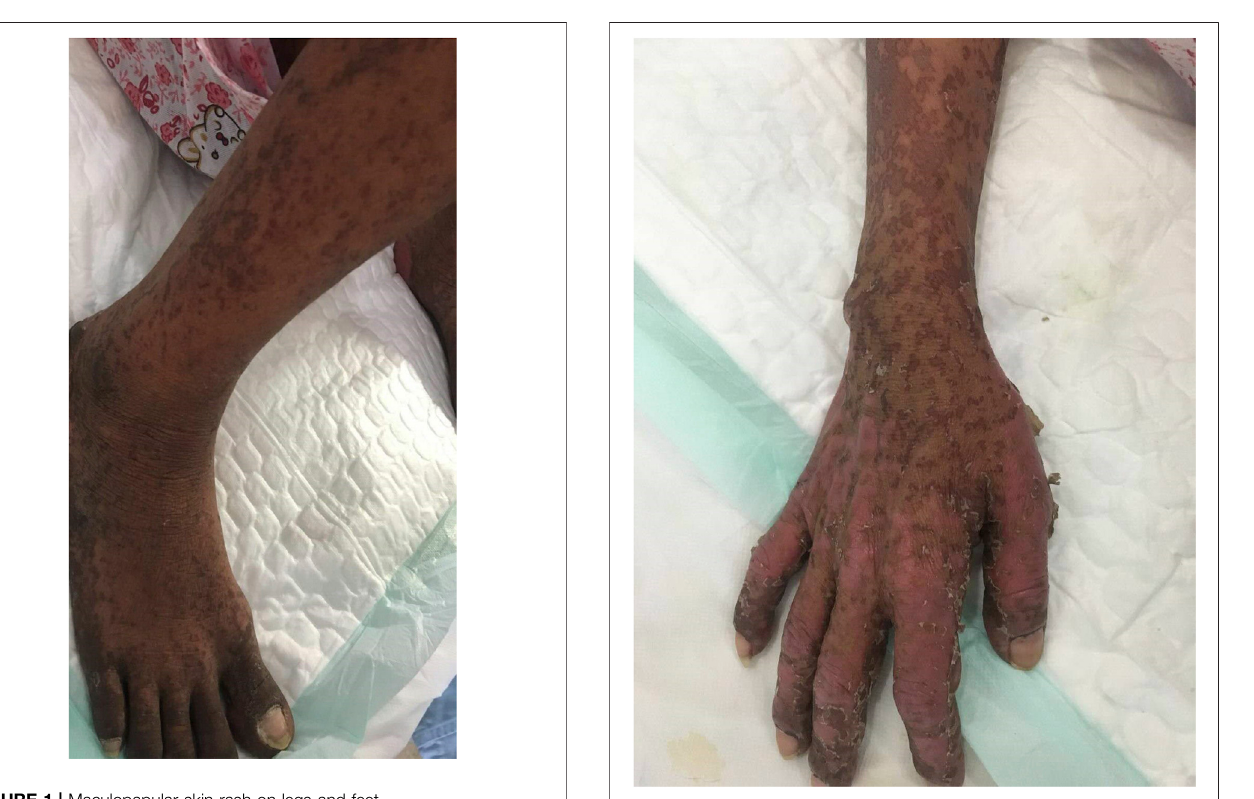
FIGURE 1 | Maculopapular skin rash on legs and feet.